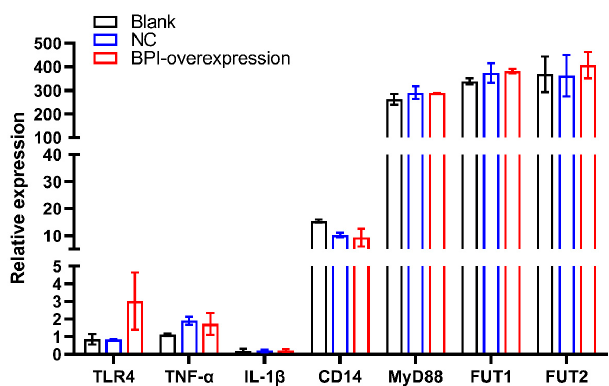
Figure 4. The impact of BPI overexpression on Toll-like receptor 4 (TLR4) signaling pathway-related gene expression and on α -(1,2) fucosyltransferase ( FUT1 , FUT2 ) gene expression. Blank: untreated control group, NC: PK15 cells transfected with the negative control lentivirus (pGLV5-NC), BPI-overexpression: PK15 cells transfected with the BPI gene overexpression lentivirus (pGLV5-BPI). Samples were analyzed in triplicate. Data are means ± standard deviation.